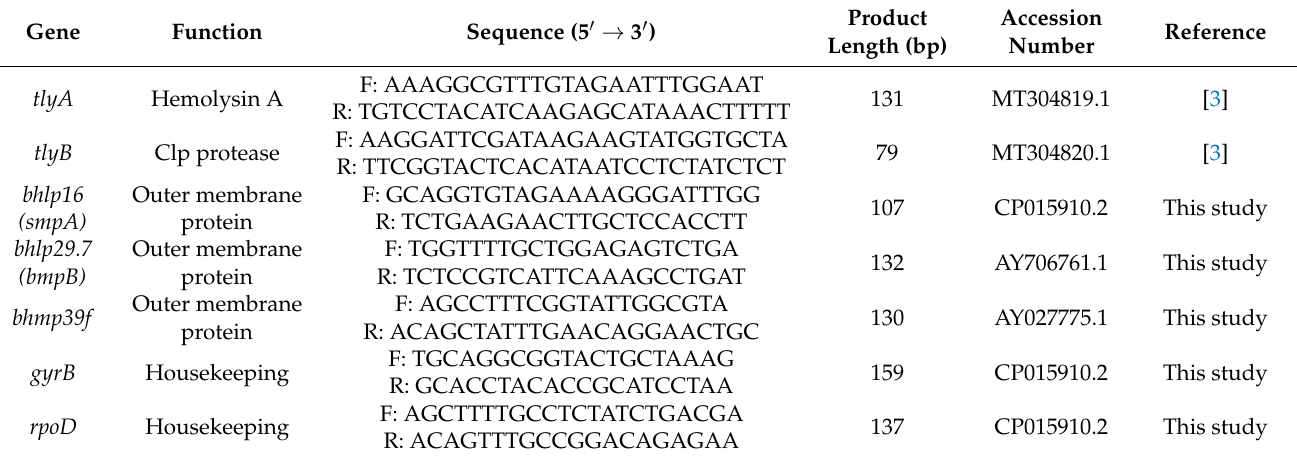
Table 1. List of primers used for real-time